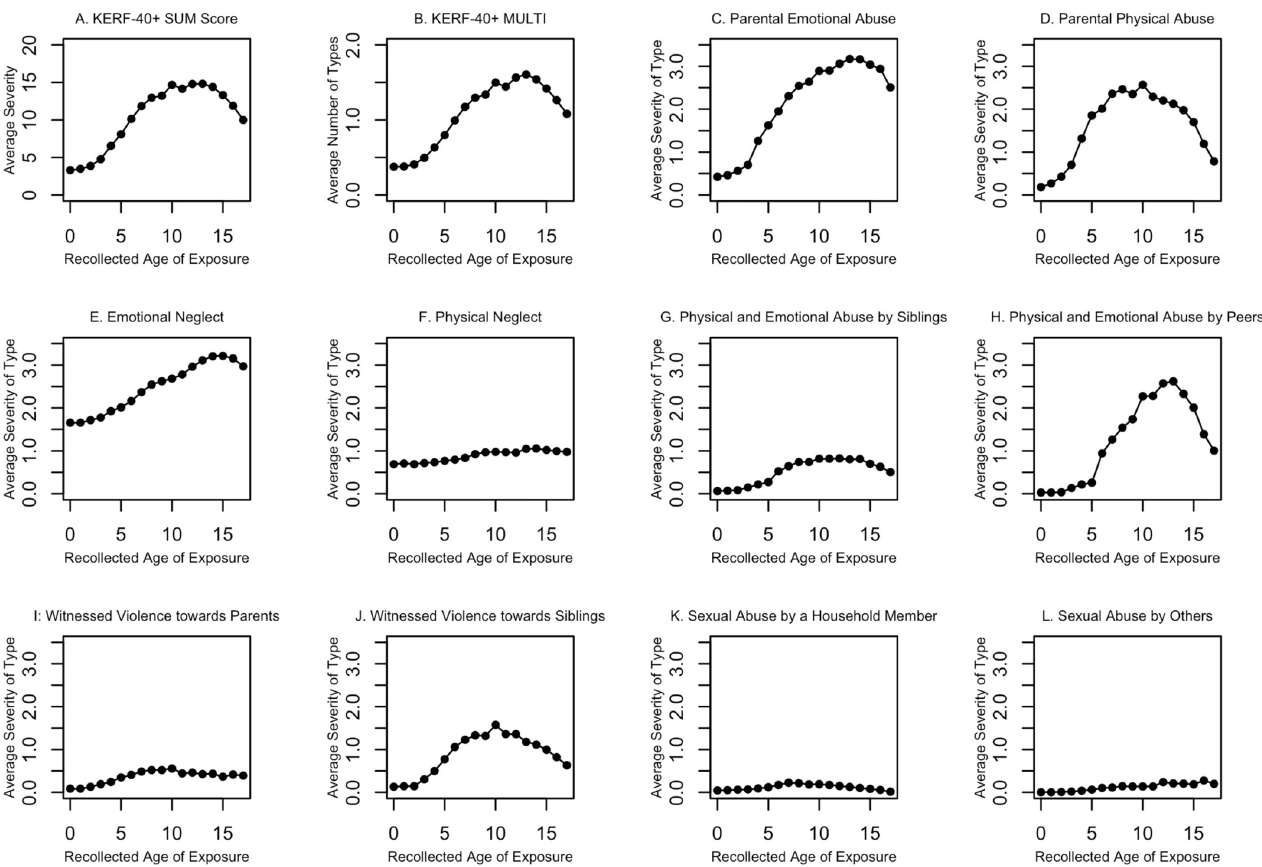
Fig 1. KERF-40+ global and subscale scores as a function of recollected age of exposure. Panel A and B show the time course of KERF-40+ global scores, including sum and multiplicity score, while panel C to L demonstrate the time course of the ten KERF-40+ subscales.